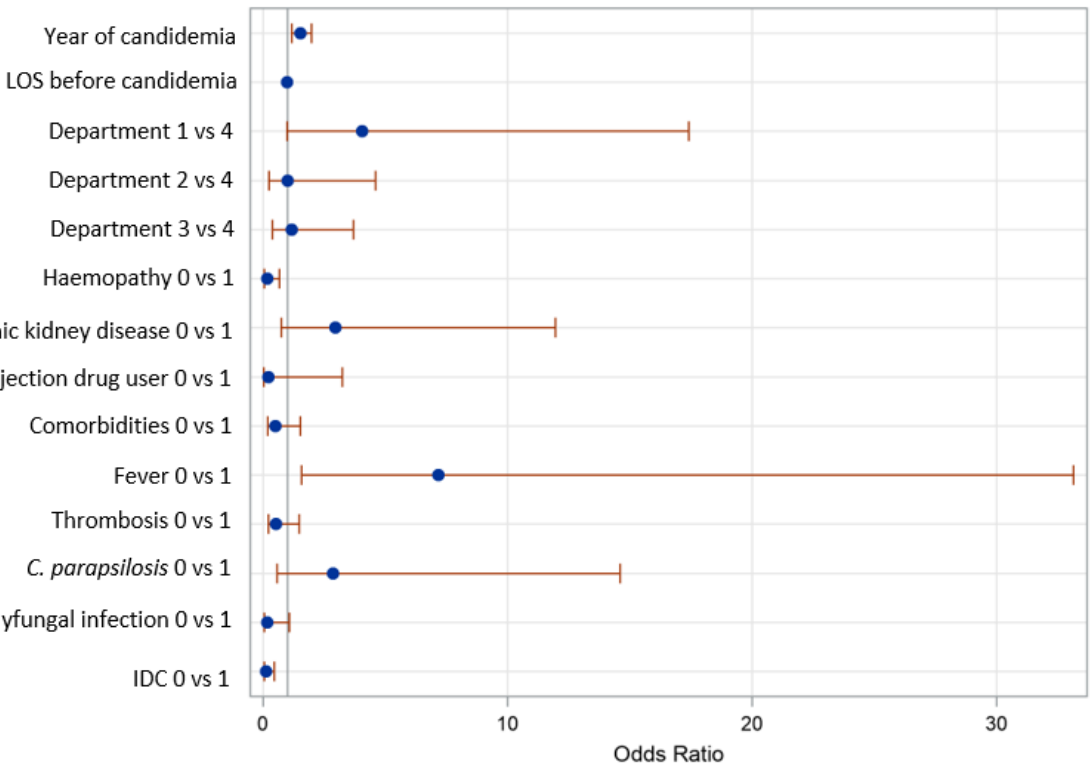
Figure A2. Multivariate analysis of factors associated with ESCMID nonadherence. Abbreviations: